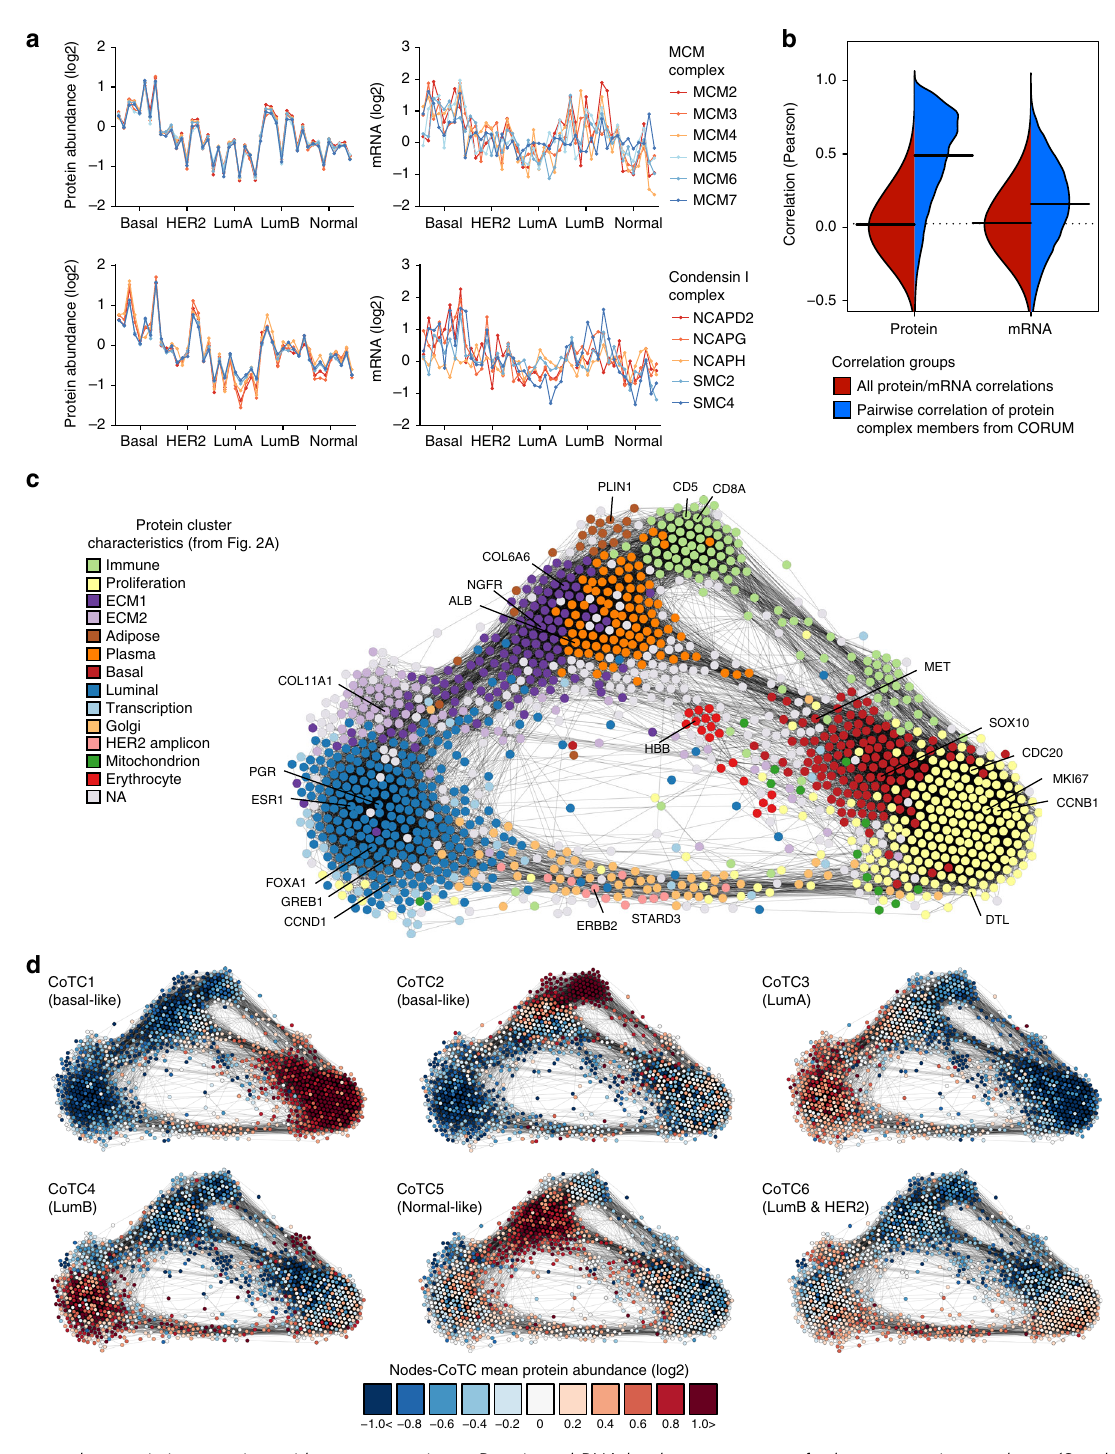
Fig. 3 Proteome characteristics associate with tumor grouping. a Protein and RNA levels across tumors for known protein complexes (Supplementary Fig. 7A, B examples of more complexes). Basal indicates basal-like and normal indicates normal-like PAM50 subtype. b Comparison of all pairwise correlations to correlations from known interaction pairs from CORUM database, using quantitative protein and RNA levels across the 45 tumors (see Supplementary Fig. 7C for same analysis using Biogrid interactions). c Breast cancer protein correlation network based on 1447 high-variance proteins using > 0.5 Pearson correlation and KCore > 1 cutoff. Protein groups are de fi ned and color coded based on GO enrichments in Fig. 2a, Supplementary Fig. 2, and 7D, E. d Visualization of average quanti fi cation of core tumor proteome consensus clusters (CoTC) in the correlation network. CoTCs are de fi ned in Fig. 2c and Supplementary Fig. 4. Main PAM50 subtype(s) for each CoTC is indicated in